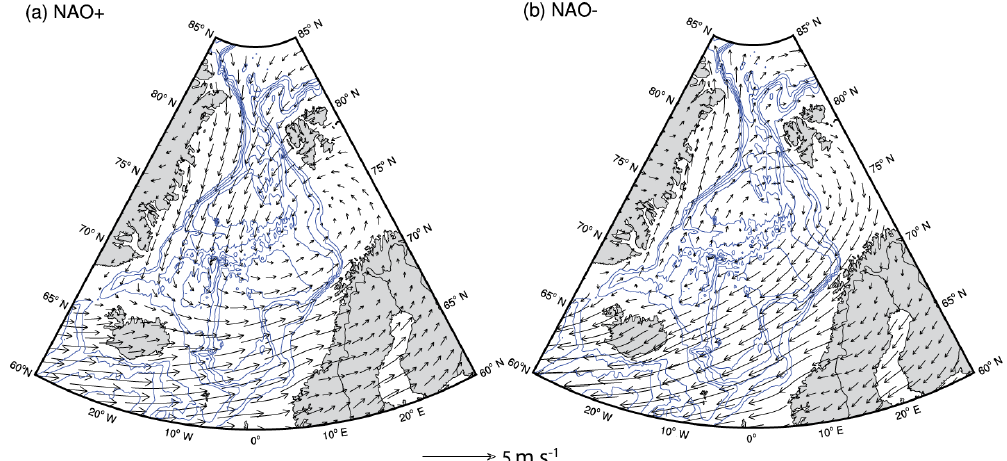
Figure 9. Composite map of anomalous winds (vectors), during (a) NAO + and (b) NAO − . Anomalies are computed using monthly clima- tology fields for the period 1991–2015. Blue isobaths are drawn for every 600m. Only significant anomalies (10% significance level) are shown.